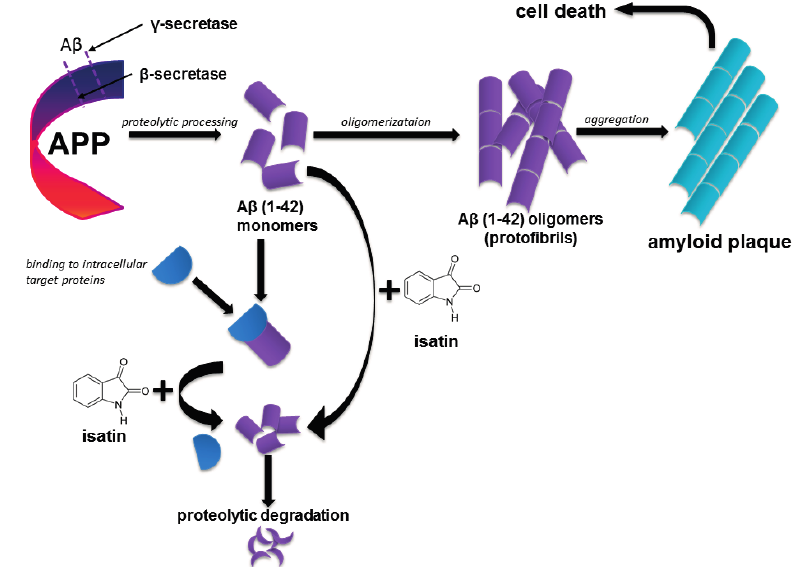
Figure 5. Proposed mechanism of isatin action in prevention of early molecular events leading to development of Alzheimer’s